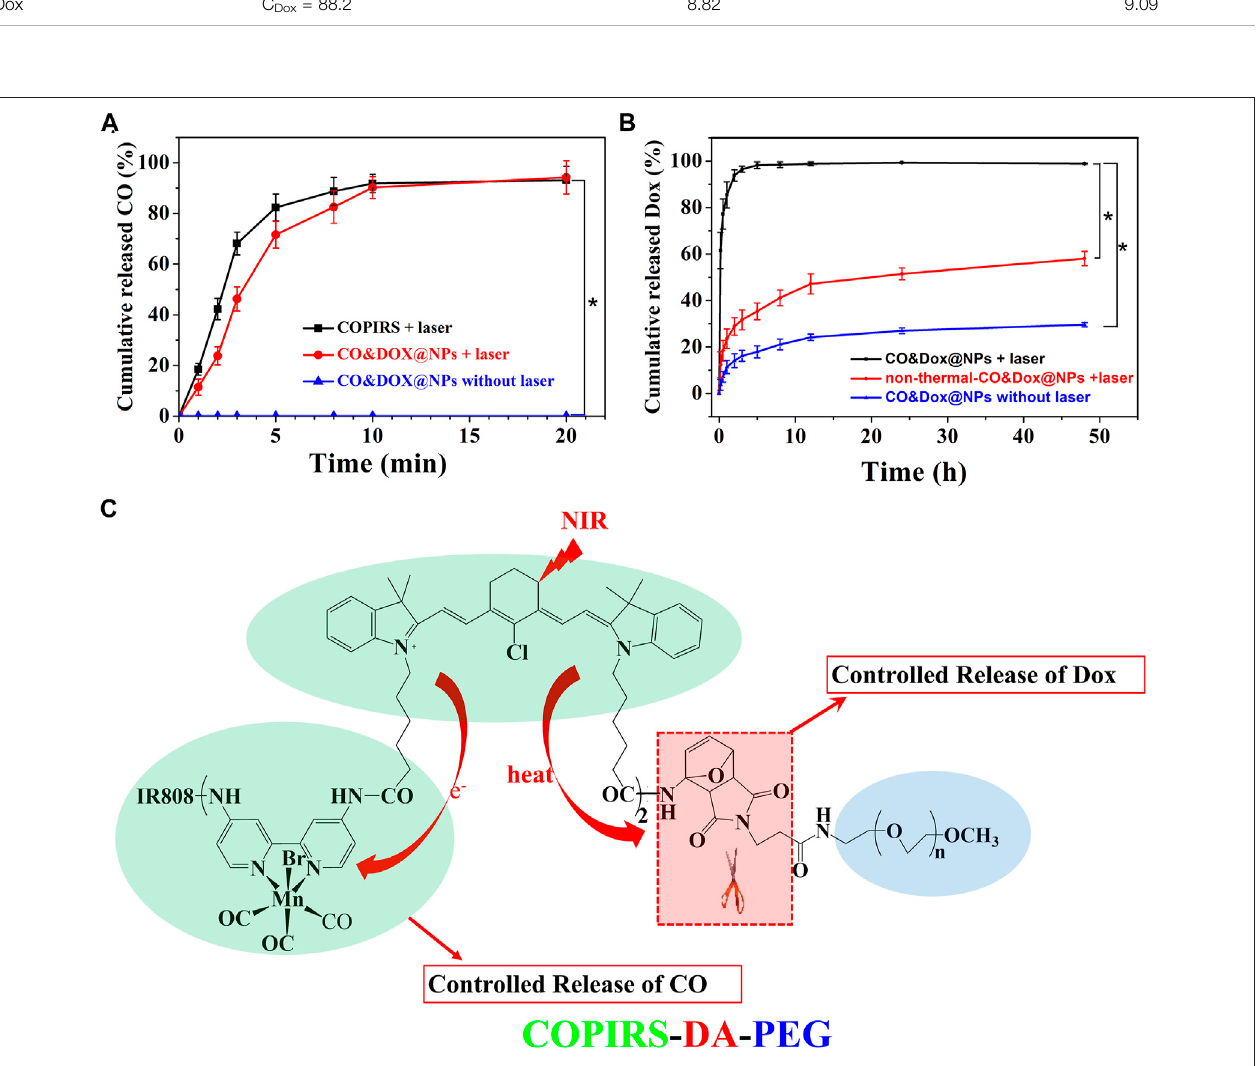
FIGURE 5 | In vitro release probe. (A) In vitro release of CO from COPIRS and CO&Dox@NPs with and without NIR laser irradiation. NIR laser (808 nm) irradiation continuedduringthetestfrom0minto20 min. (B) Invitro releaseofDoxfromCO&Dox@NPswithandwithoutNIRlaserirradiationandnone-thermallyresponsivenone- thermal-CO&Dox@NPs with irradiation; 10 min of NIR laser (808 nm) irradiation were performed before the test. * p < 0.001. (C) The mechanism of the spatial and temporal consistency of the controlled release of CO and drug under near-infrared light (NIR, 808 nm).